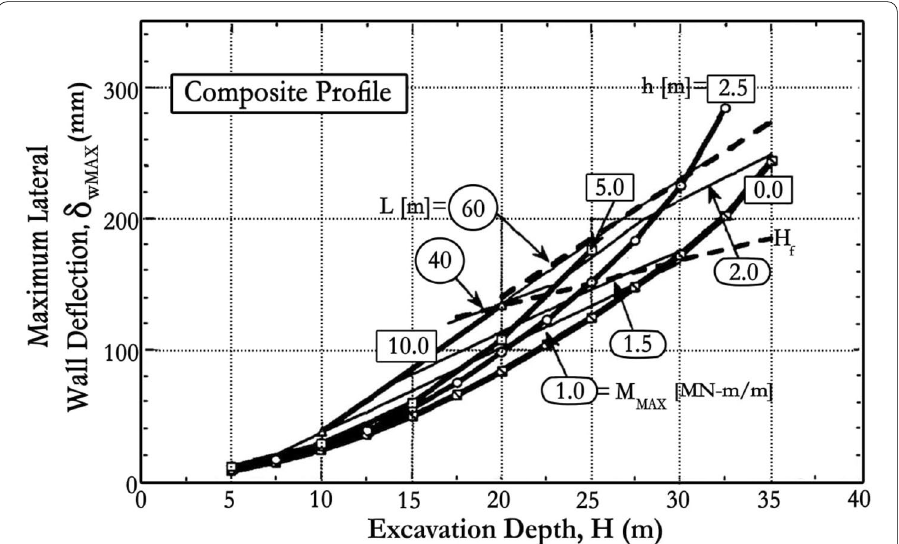
Fig. 1 design chart obtained by Hashash and Whittle